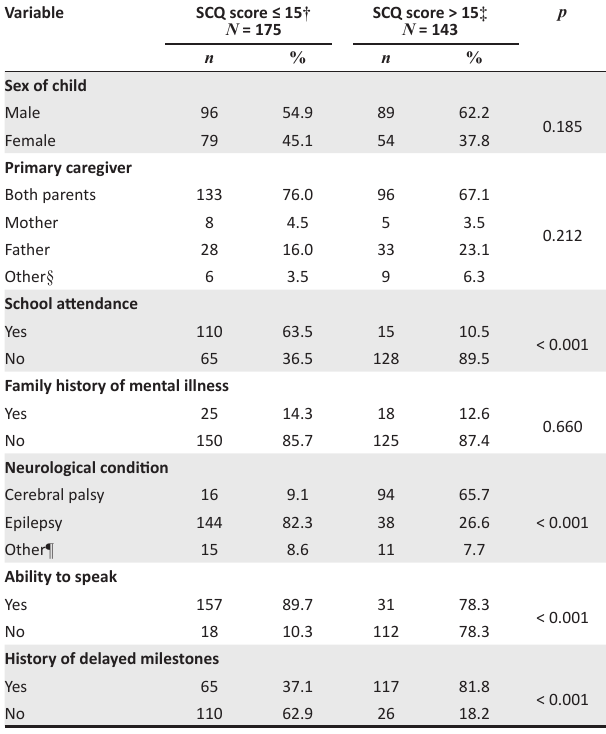
TABLE 3: Bivariate analysis of socio-demographic and clinic characteristics of the study